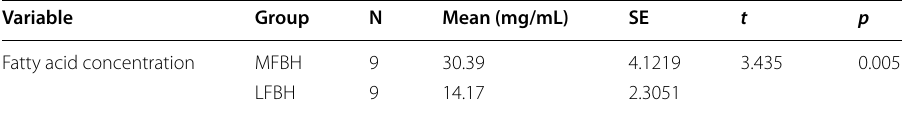
Table 4 Result of independent t -test on the change of concentration of fatty acids in the MFBH group and the LFBH group after 21 days of hair treatment application Variable